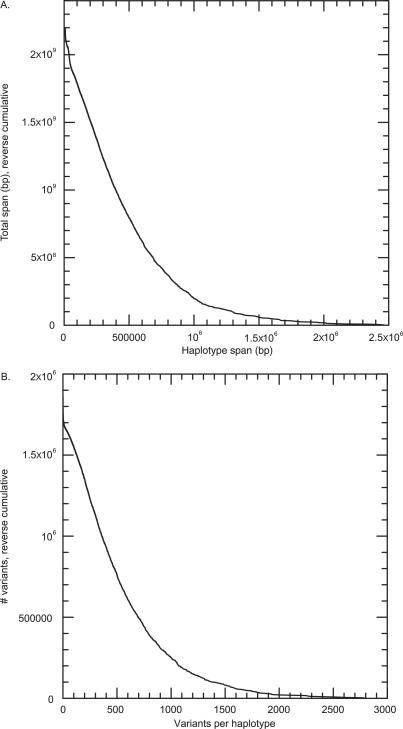
Distribution of Inferred Haplotype Sizes(A) Reverse cumulative distribution of haplotype spans (bp) (N50 ∼ 350 kb). (B) Reverse cumulative distribution of variants per haplotype (N50 ∼ 400 variants).